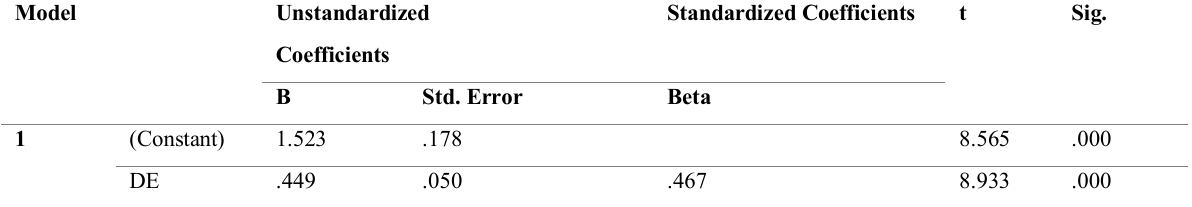
Table 5: Coefficient for Regression of LD against